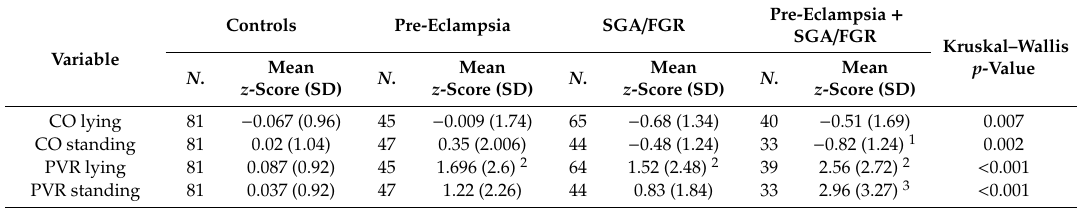
Table 2. Comparison of cardiac output and peripheral vascular resistance z -scores in pathological outcome groups.